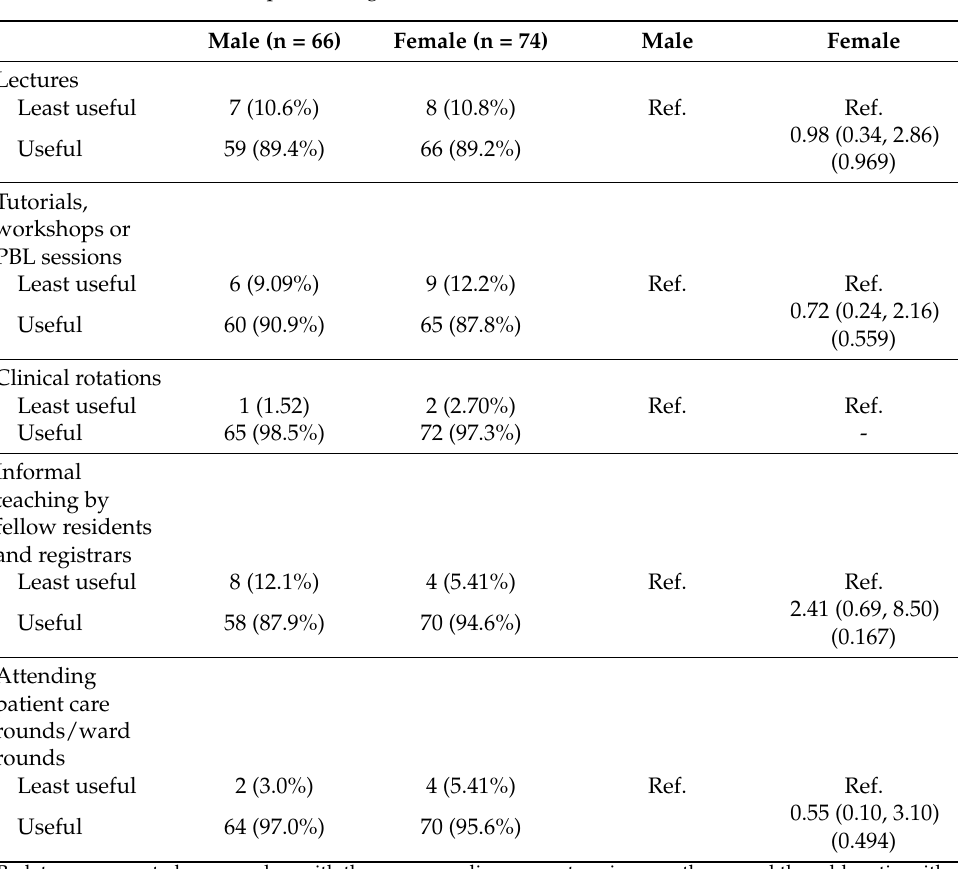
Table 5. Frequency and odds of gender in the relative effectiveness of various modes of delivery of education instruction in gaining and retaining the knowledge of medicines and prescribing, including but not limited to antibiotics prescribing.